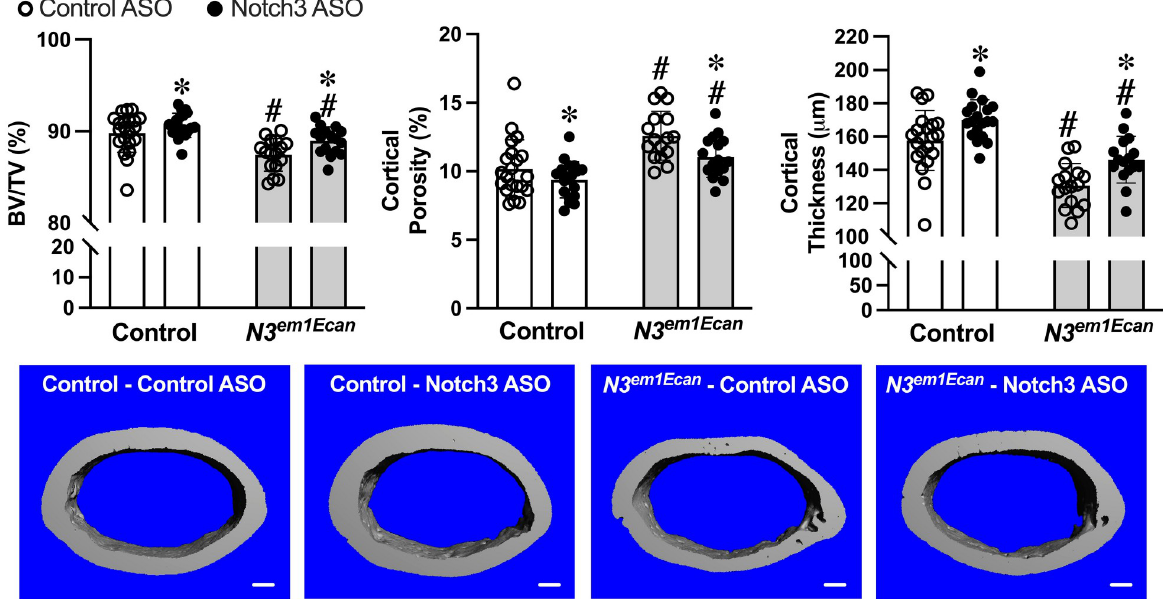
Fig 5. Cortical bone microarchitecture assessed by μ CT of the mid-diaphyseal femur from 8.5–9week old Notch3 em1Ecan mutant (gray bars) male mice and sex-matched littermate controls (white bars) treated with Notch3 ASO (closed circles; n = 19 for control, n = 16 for Notch3 em1Ecan ) or control ASO (open circles; n = 21 for control, n = 16 for Notch3 em1Ecan ) both at 50 mg/kg subcutaneously, once a week for 4 weeks prior to sacrifice. Parameters shown are cortical bone volume/total volume (BV/TV, %), cortical porosity (%), and cortical thickness (mm). Individual values are shown, and bars and ranges represent means ± SD of biological replicates. � Significantly different between Notch3 and control ASO, p < 0.05. #Significantly different between Notch3 em1Ecan and control, p < 0.05. Representative images show cortical bone osteopenia in Notch3 em1Ecan mutant mice and its amelioration by Notch3 ASOs. Scale bars in the right corner represent 100 μ